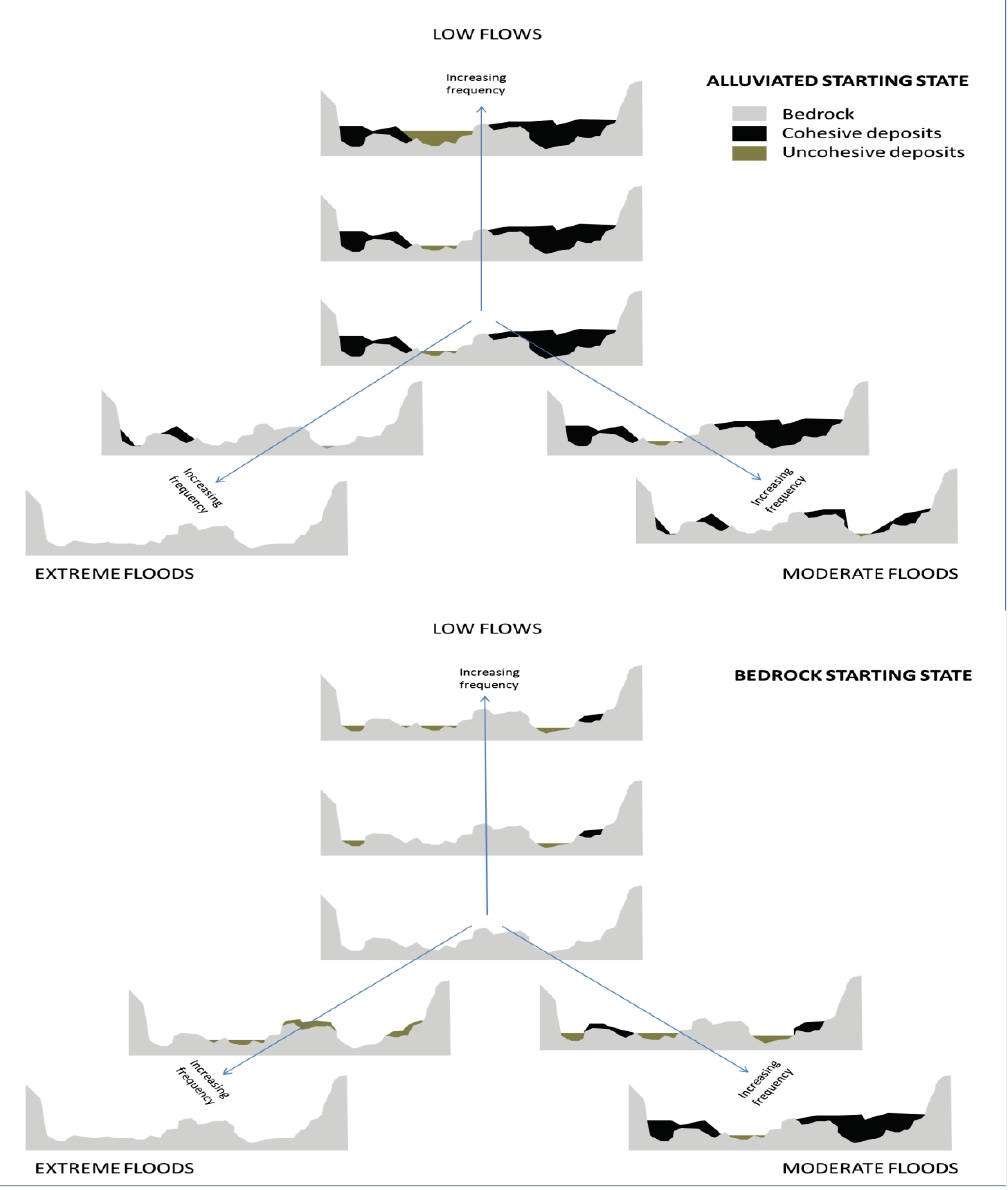
Fig. 4 A revised model of channel development for the Sabie and Olifants rivers, South Africa. Direction of change is from the central starting state